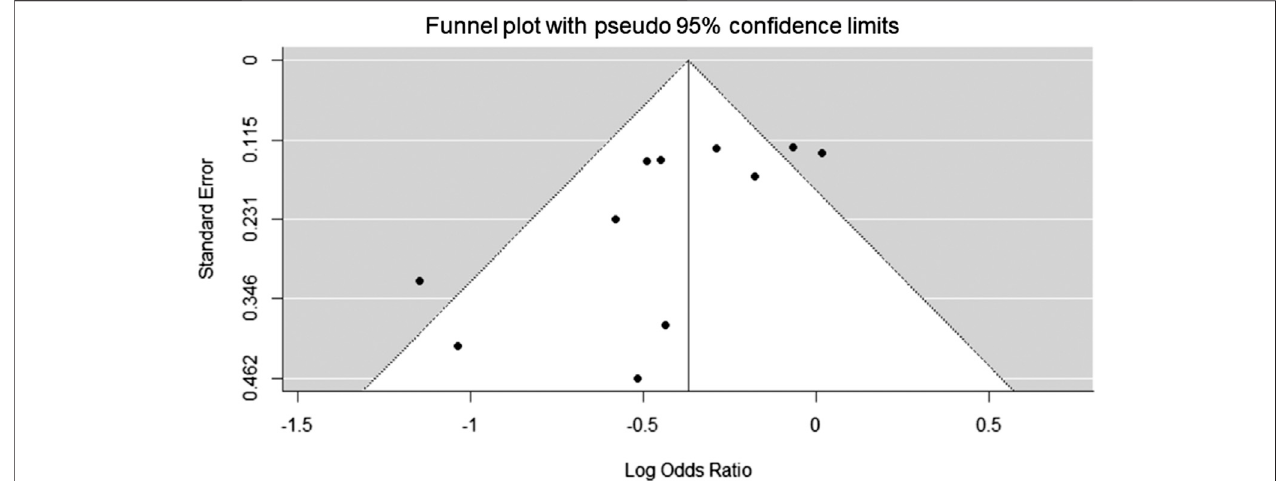
FIGURE 3 | Funnel plot of